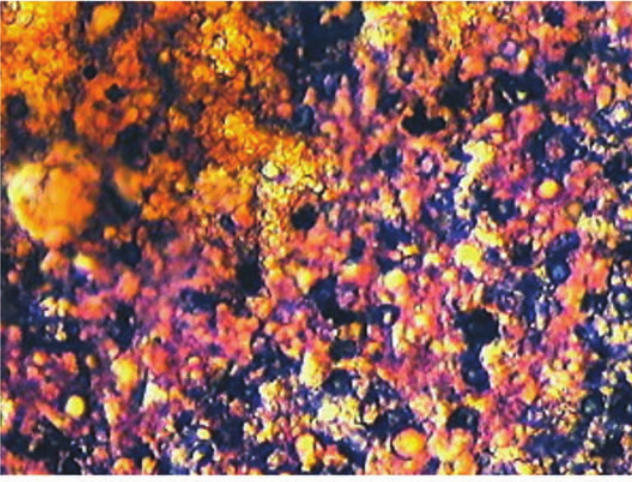
Figure 4. Differential laboratory staining of marine nannofossils (coccoliths and coccolithophores) in a layer of coccolithic limestone from the Upper Jurassic, Upper Kimmeridge Clay, Hounstout Cliff, Dorset coast (UK). The area of golden colored coccoliths is actually not stained, as these are buried in transparent kerogen. The pink nannofossils testify to a pure calcite composition. The dark blue nannofossils testify to a ferroan calcite composition, where Fe impurities are present in the calcite lattice (figure and comment from Abineri